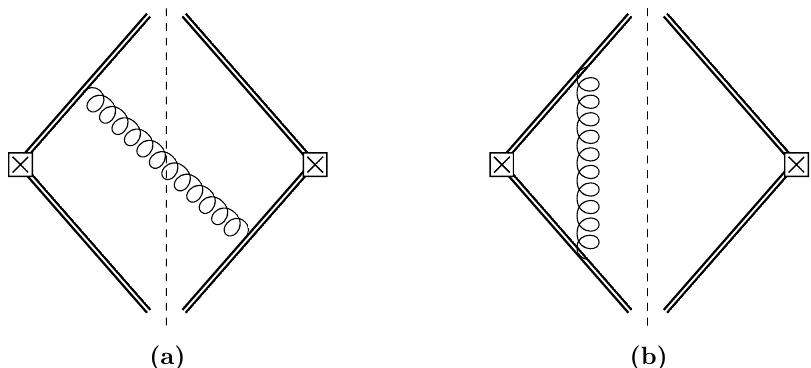
Figure 22. Diagrams relevant for computation of the partonic soft function at